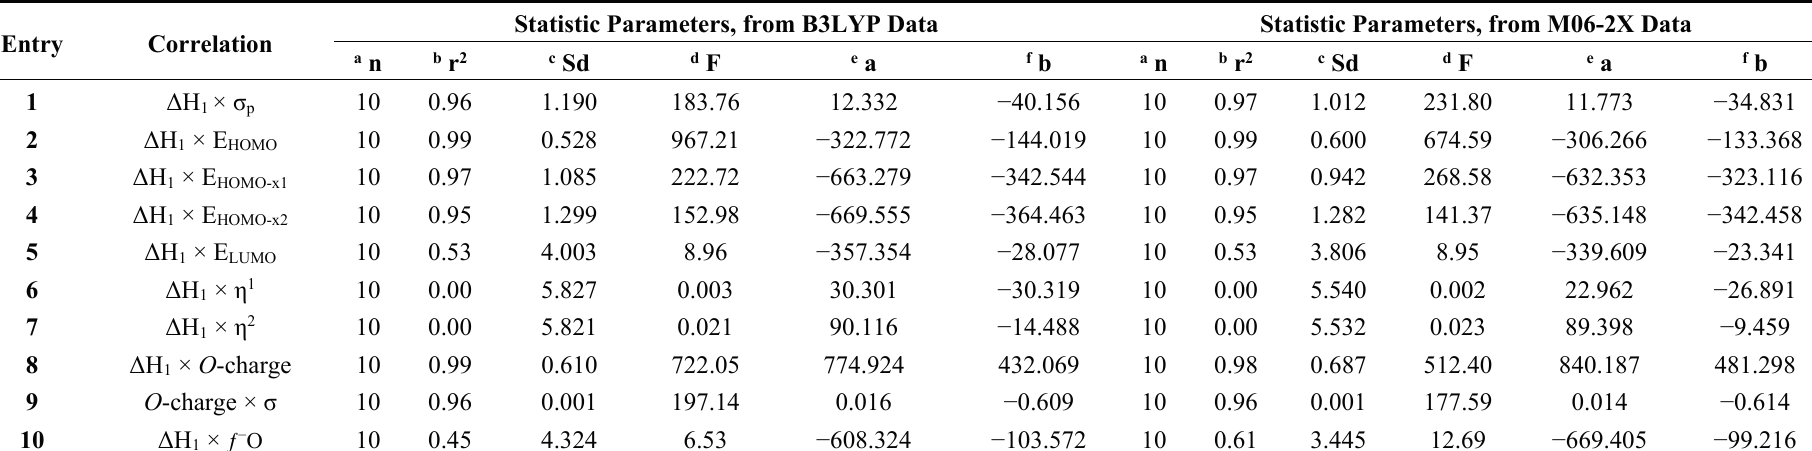
Table 3. Correlations analysis between local properties and enthalpy variation for 4- or 3-X-cinnamic acid protonation (Step 1), obtained from B3LYP and M06-2X